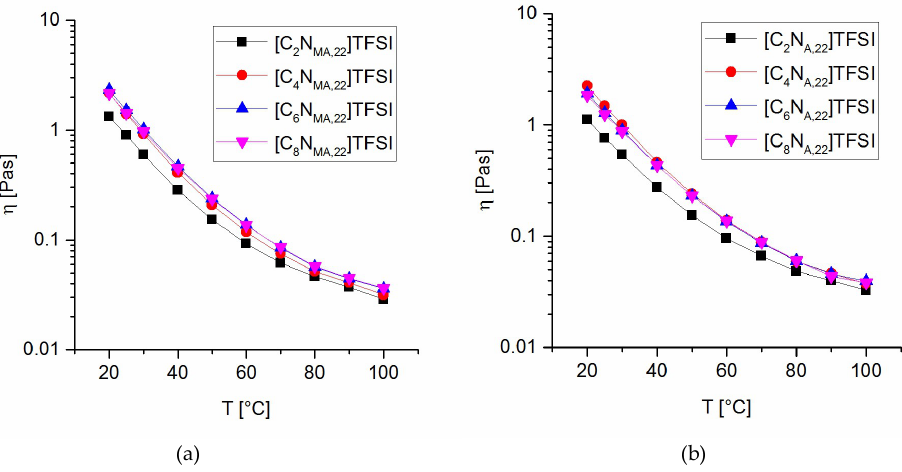
Figure 4. Viscosity values at various temperatures for methacrylate ILs ( a ) and acrylate ILs ( b ).